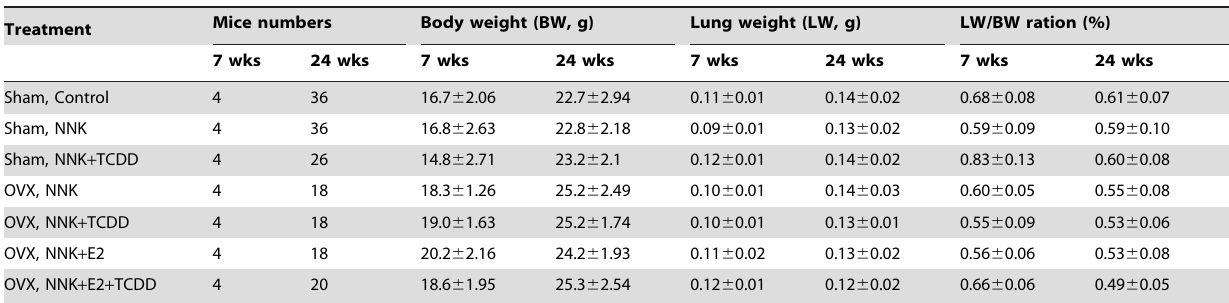
NNK, E2, and TCDD effects on lung and body weight increases after treatment for 7 or 24 weeks